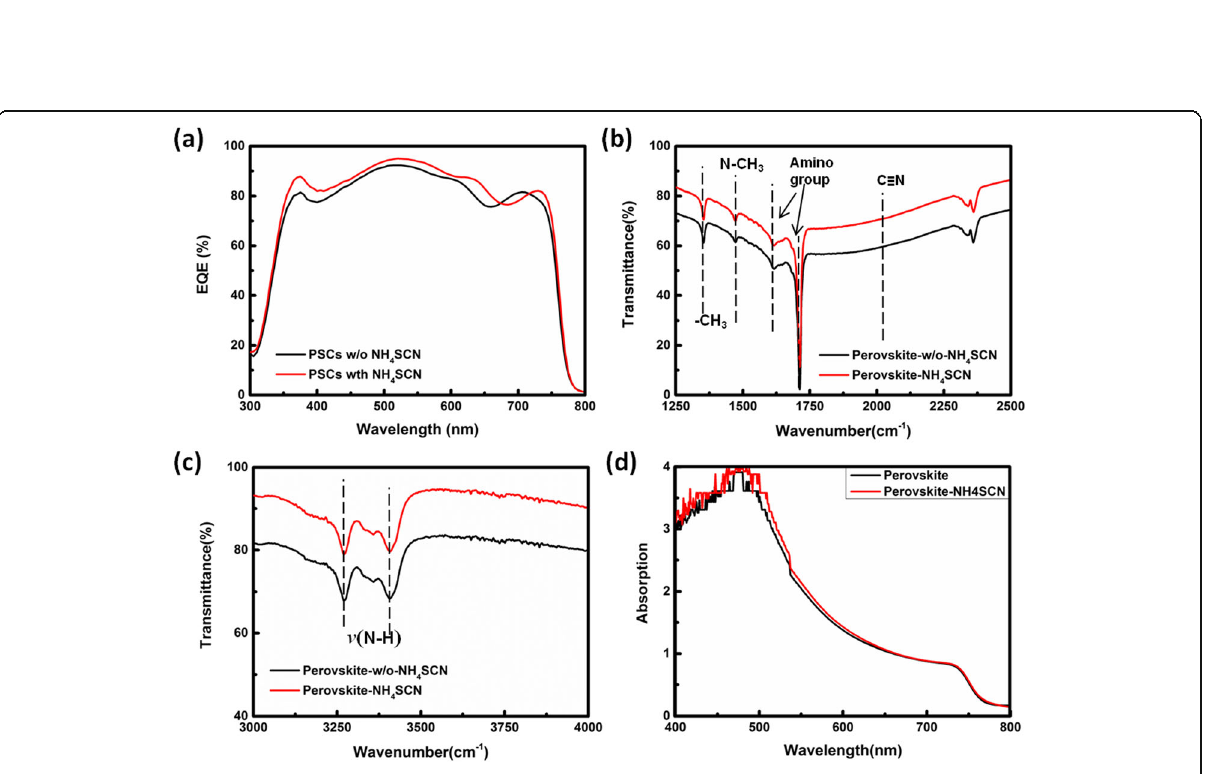
Fig. 3 a EQE spectrum of target PSCs (PSCs with NH 4 SCN) and reference PSCs (PSCs w/o NH 4 SCN). b , c FTIR results of the perovskite-w/o- NH 4 SCN films and perovskite-NH 4 SCN films. d UV-vis absorption spectrum of the perovskite-w/o-NH 4 SCN films and perovskite-NH 4 SCN